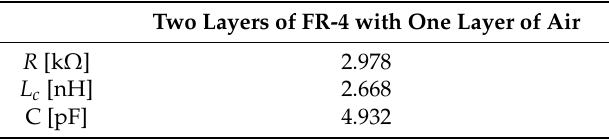
Table 6. Values obtained from the RLC equivalent circuit.